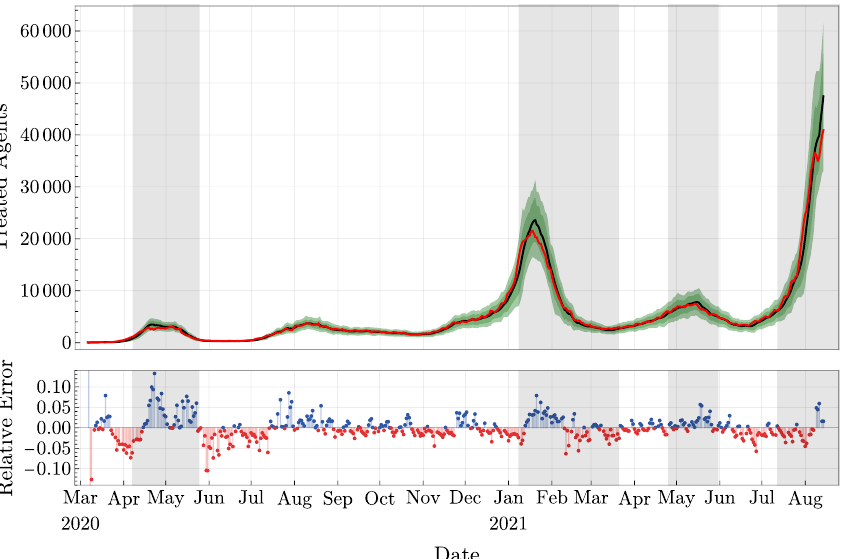
Figure 6. Upper part : Treated agents T , with the observation values in red and the analyzed mean values in black. 68%, resp. 90%, confidence interval are indicated in green. Lower part : Relative difference for the mean values of 1-day forecast and analyzed T .